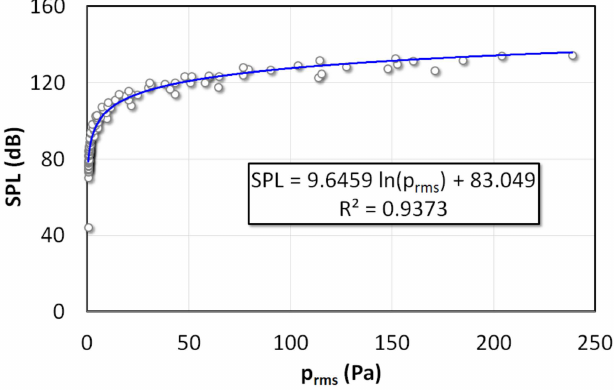
Figure 2. Calibration of the SPL meter with respect to root mean square pressure